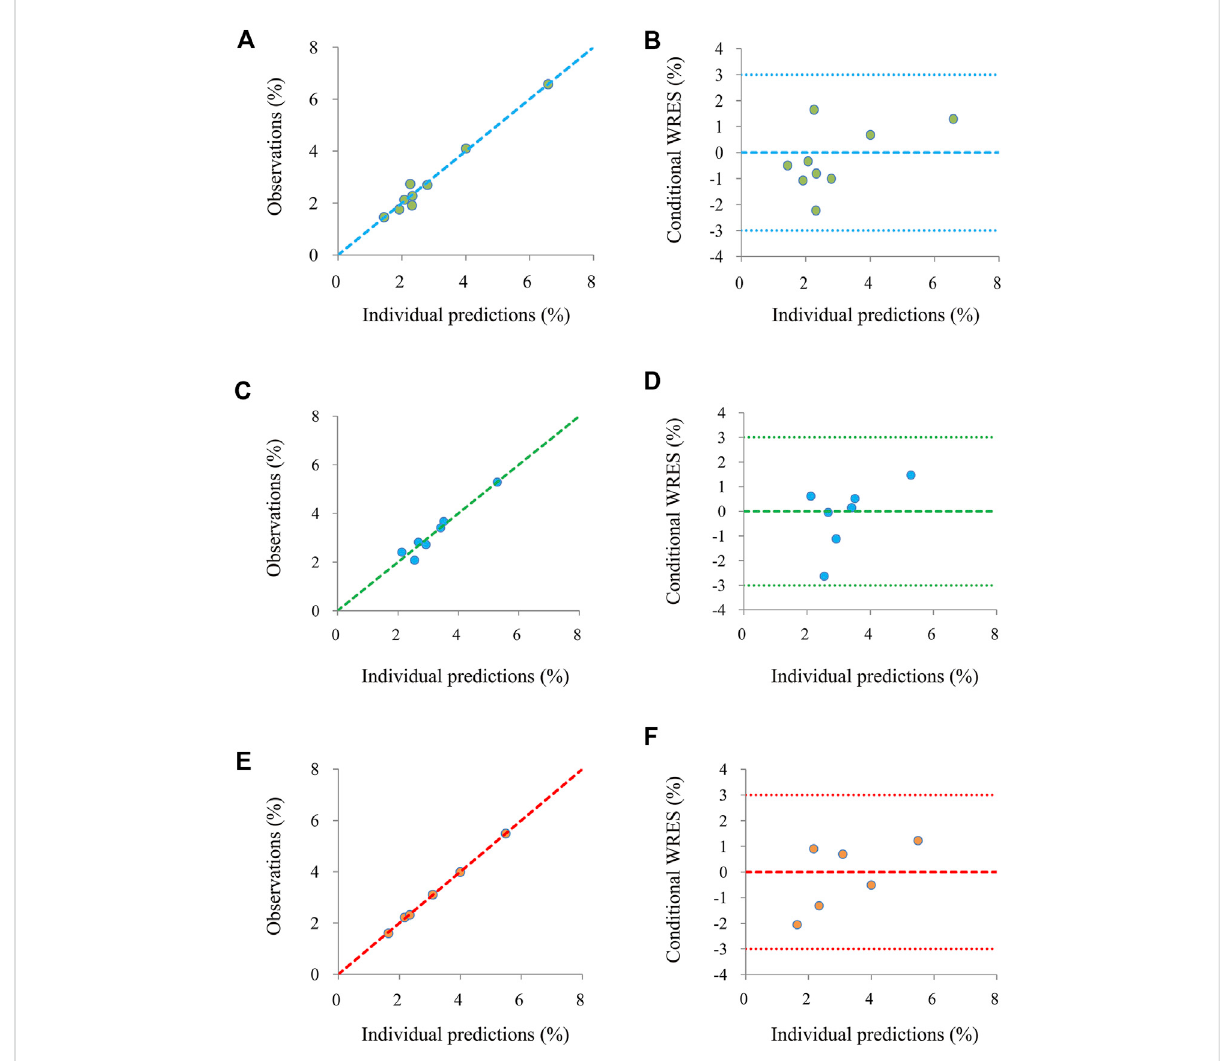
FIGURE 1 Model evaluation. (A,B) were from the CSS, (C,D) were from the TSS, and (E,F) were from the OSS. CSS: clinical summary score; TSS: total symptom score; OSS: overall summary